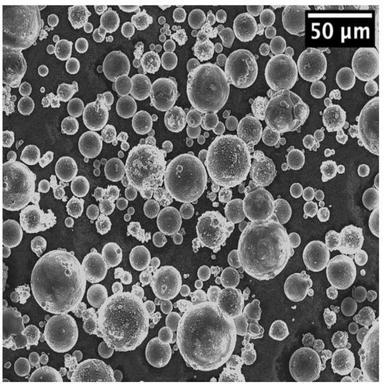
Secondary electron image of Al-14Zn-3Mg powder, showing spherical morphology and size range.